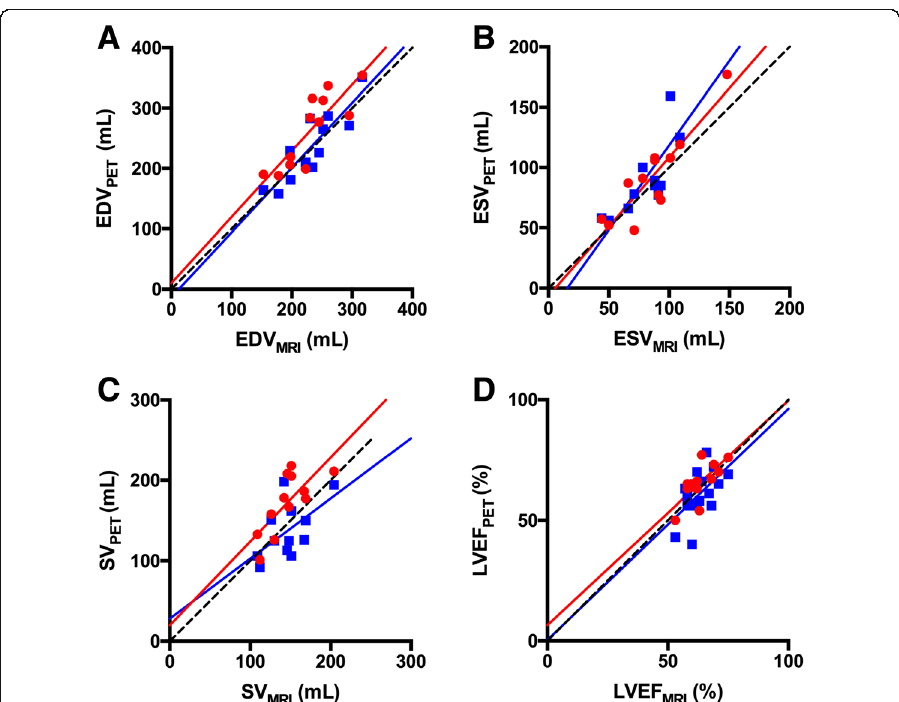
Fig. 3 Correlation between 15 O-water PET volume-based method and MRI ESV ( a ), EDV ( b ), SV ( c ) and LVEF ( d ). Circles (red) are values from V B images, and squares (blue) are values from FP images. Solid lines are linear regression lines, and dashed lines are lines of identity. Outliers were removed